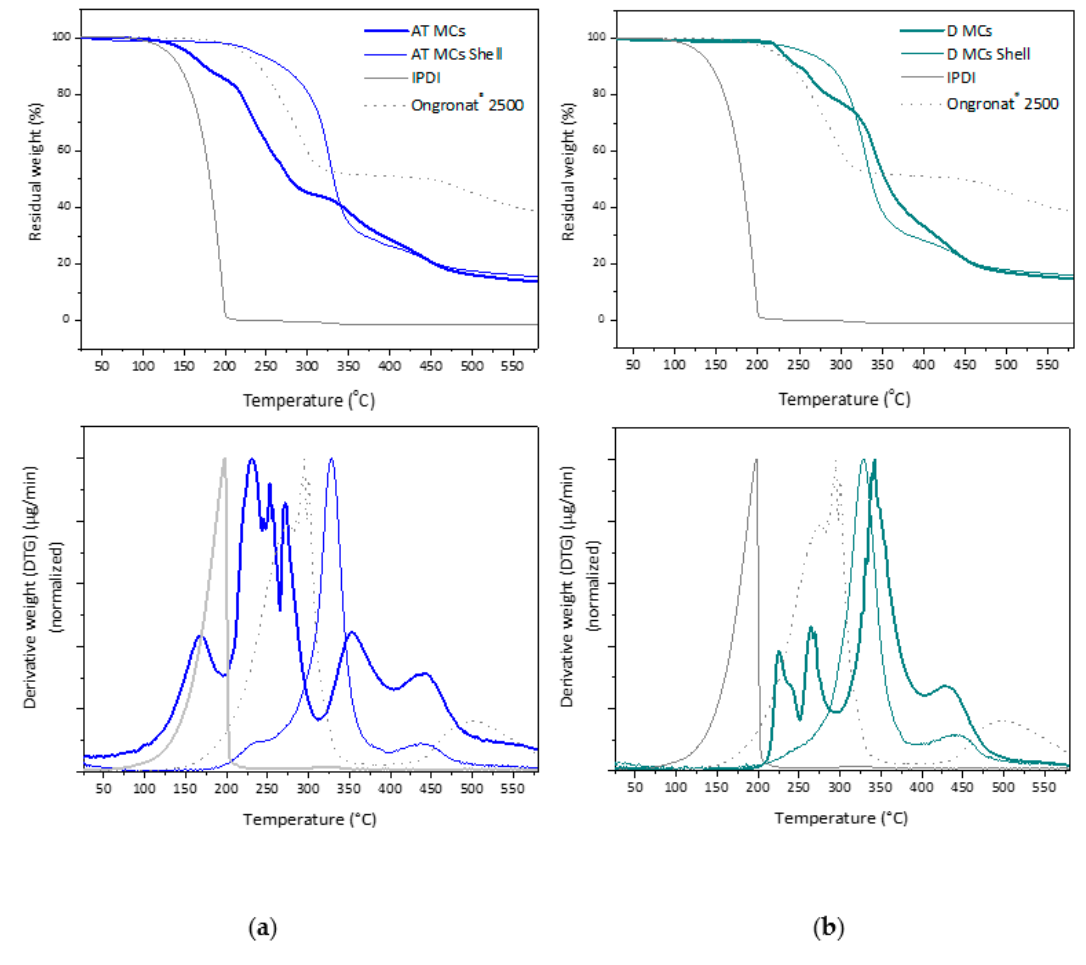
Figure 11. ( a ) Thermograms of the AT MCs, the respective shell and the isocyanates used in the synthesis ( top ) and respective first derivative curves ( bottom ); and ( b ) thermograms of the D MCs, the respective shell and the isocyanates used in the synthesis ( top ) and respective first derivative curves ( bottom ).